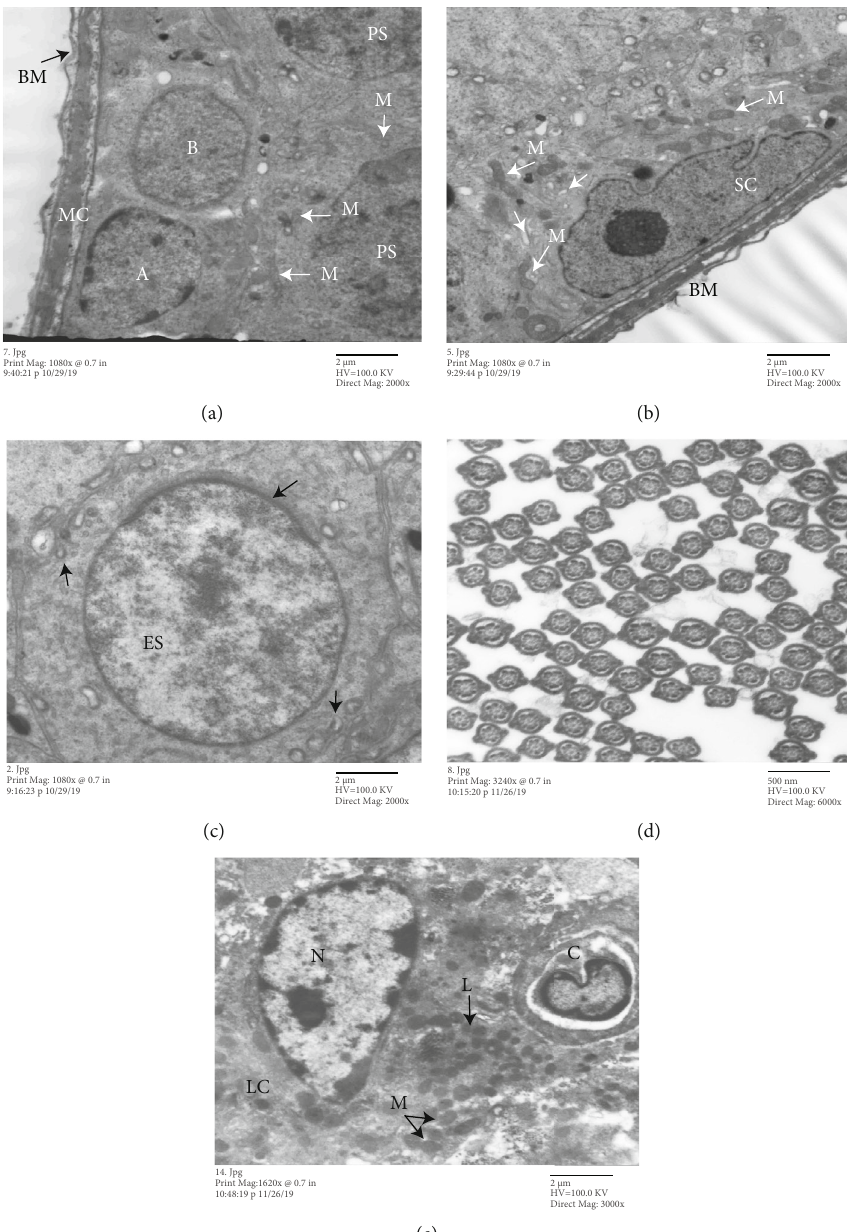
Figure 5: Electron micrographs of a seminiferous tubule of a control rat. (a) Normal basement membrane (BM), the myoid cell with the fl at nucleus (MC), mitochondria (M), type A and B spermatogonia, and primary spermatocyte (PS). (b) Sertoli cell (SC), mitochondria (M), and smooth endoplasmic reticulum (sER) (arrowhead). (c) Early spermatid (ES), apical acrosomal cap (arrow), and peripheral mitochondria (arrowhead). (d) Cross section in mature sperms inside the tubule lumen having a central axoneme surrounded by outer dense fi bres and fi brous sheath. (e) Interstitial tissue with blood capillary (C), Leydig cells (LC), large open-face nucleus (N), mitochondria (M), and lipid droplets (L) ((a) – (c): TEM, × 2000; (d): × 6000; and (e): ×